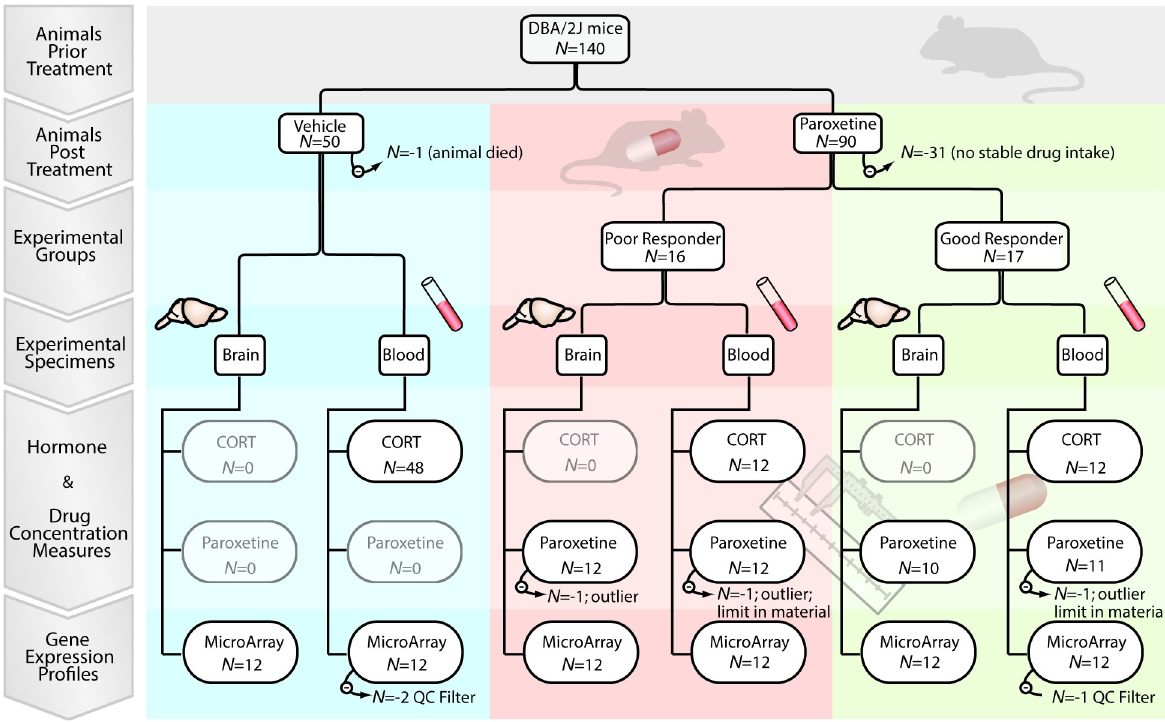
Fig 2. Flowchart for the entire experimental procedure. Summary figure illustrating the sequential steps of experiments and analyses appliedin this study, indicatingthe experimental groupsand group sizes for each condition. CORT, corticosterone; QC, qualitycontrol.